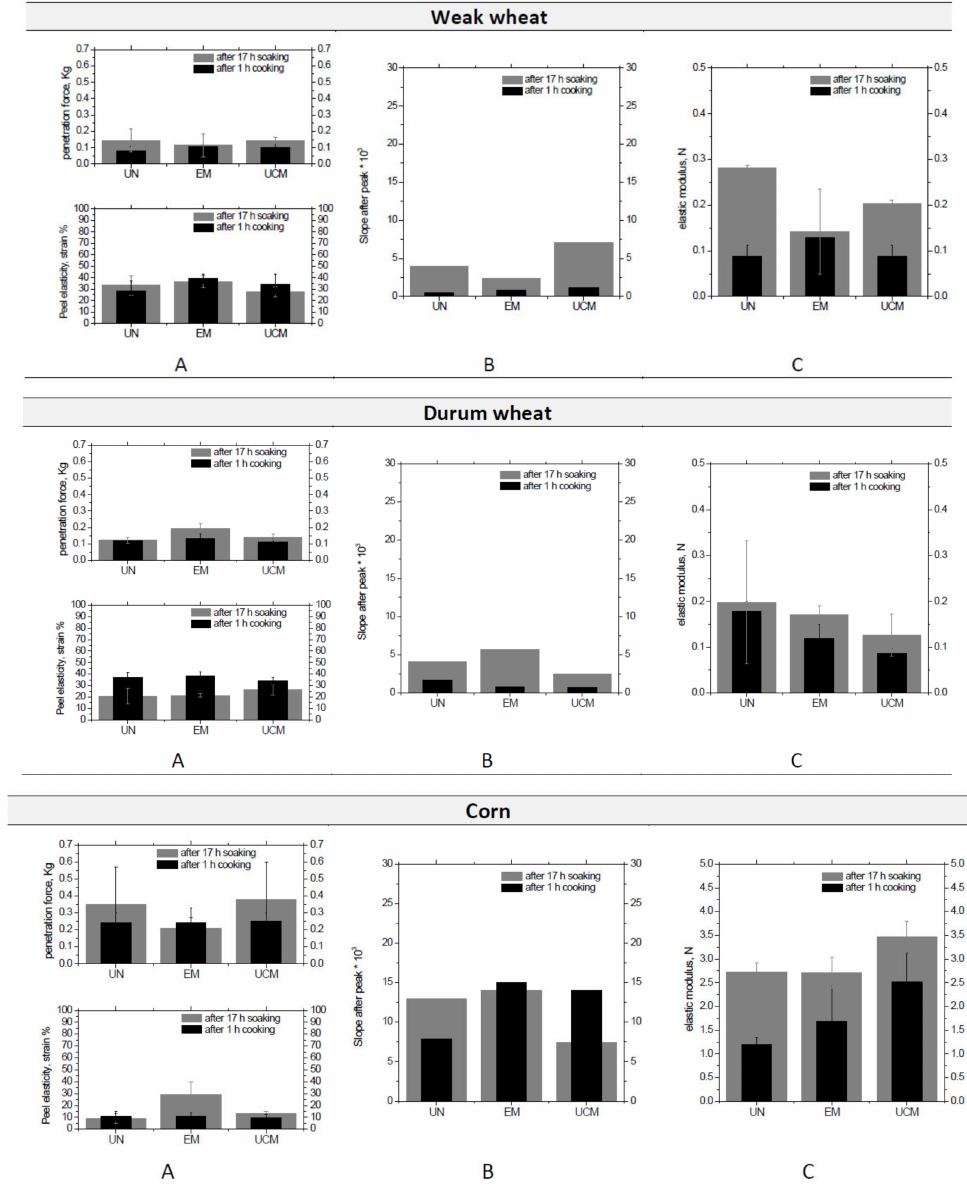
Figure 4. Penetration and compression tests results for the three analyzed matrices: comparison of the penetration force and the relevant strain % ( A ) and the slope after the peak ( B ) for the penetration test, and of the elastic modulus ( C ) for the compression test between samples after 17 h swelling and 1 h